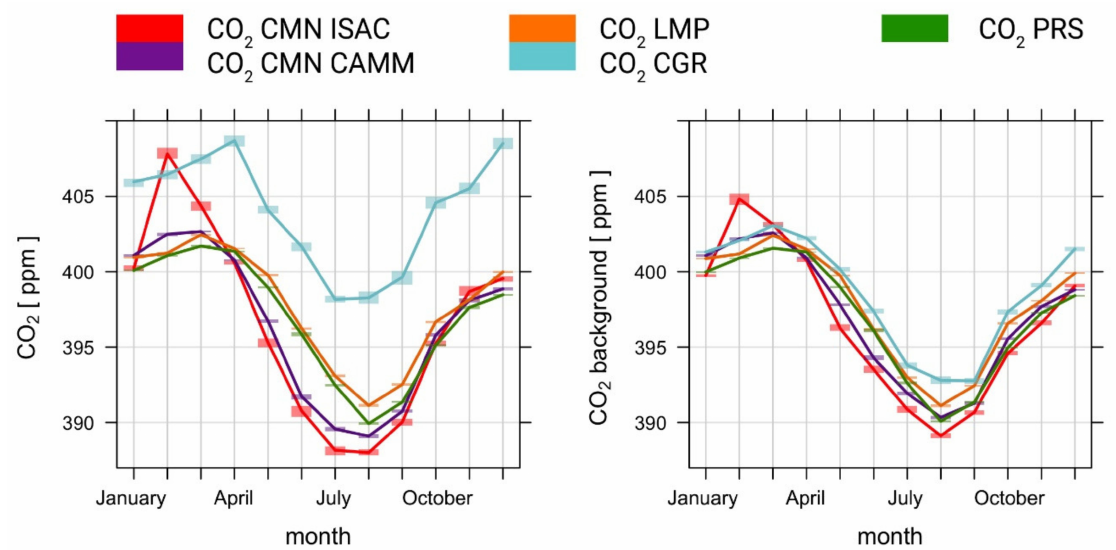
Figure 5. Left, annual cycle of the detrended monthly mean CO 2 ; right, annual cycle of the detrended monthly mean CO 2 for background data. Data for PRS (green), CMN—ISAC (red), CMN—CAMM (purple), CGR (light blues) and LMP (orange). The shaded areas denote the 95% confidence